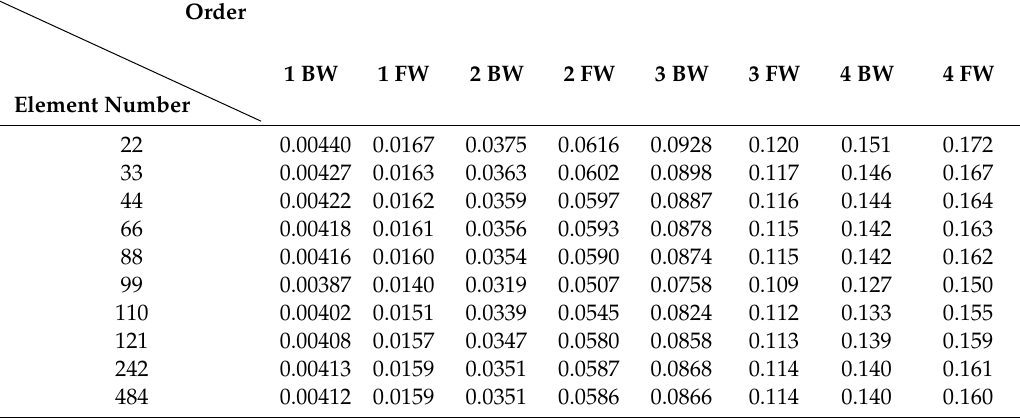
Table 15. Natural frequencies via spatial discretization ( h = 1000 Nms).